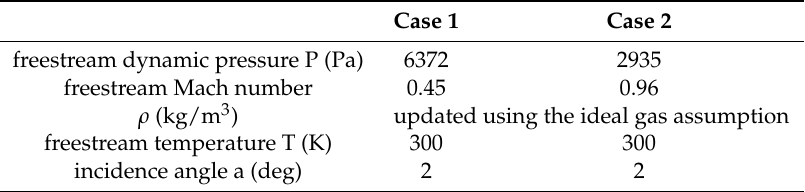
Table 4. Aeroelastic analysis envelope for the AGARD 445.6 case.